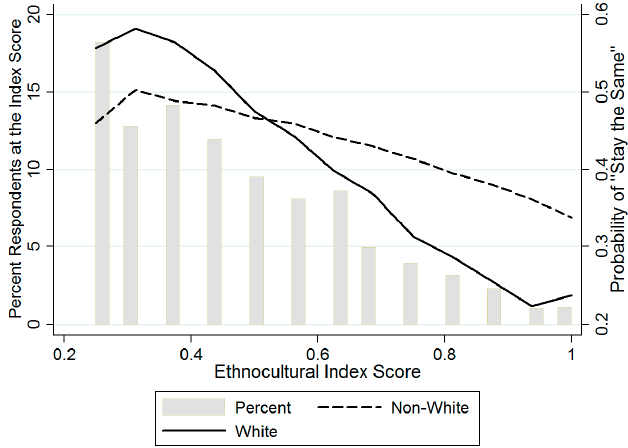
Figure 7. Predicted probability of “stay the same” response by race and ethnocultural index score.